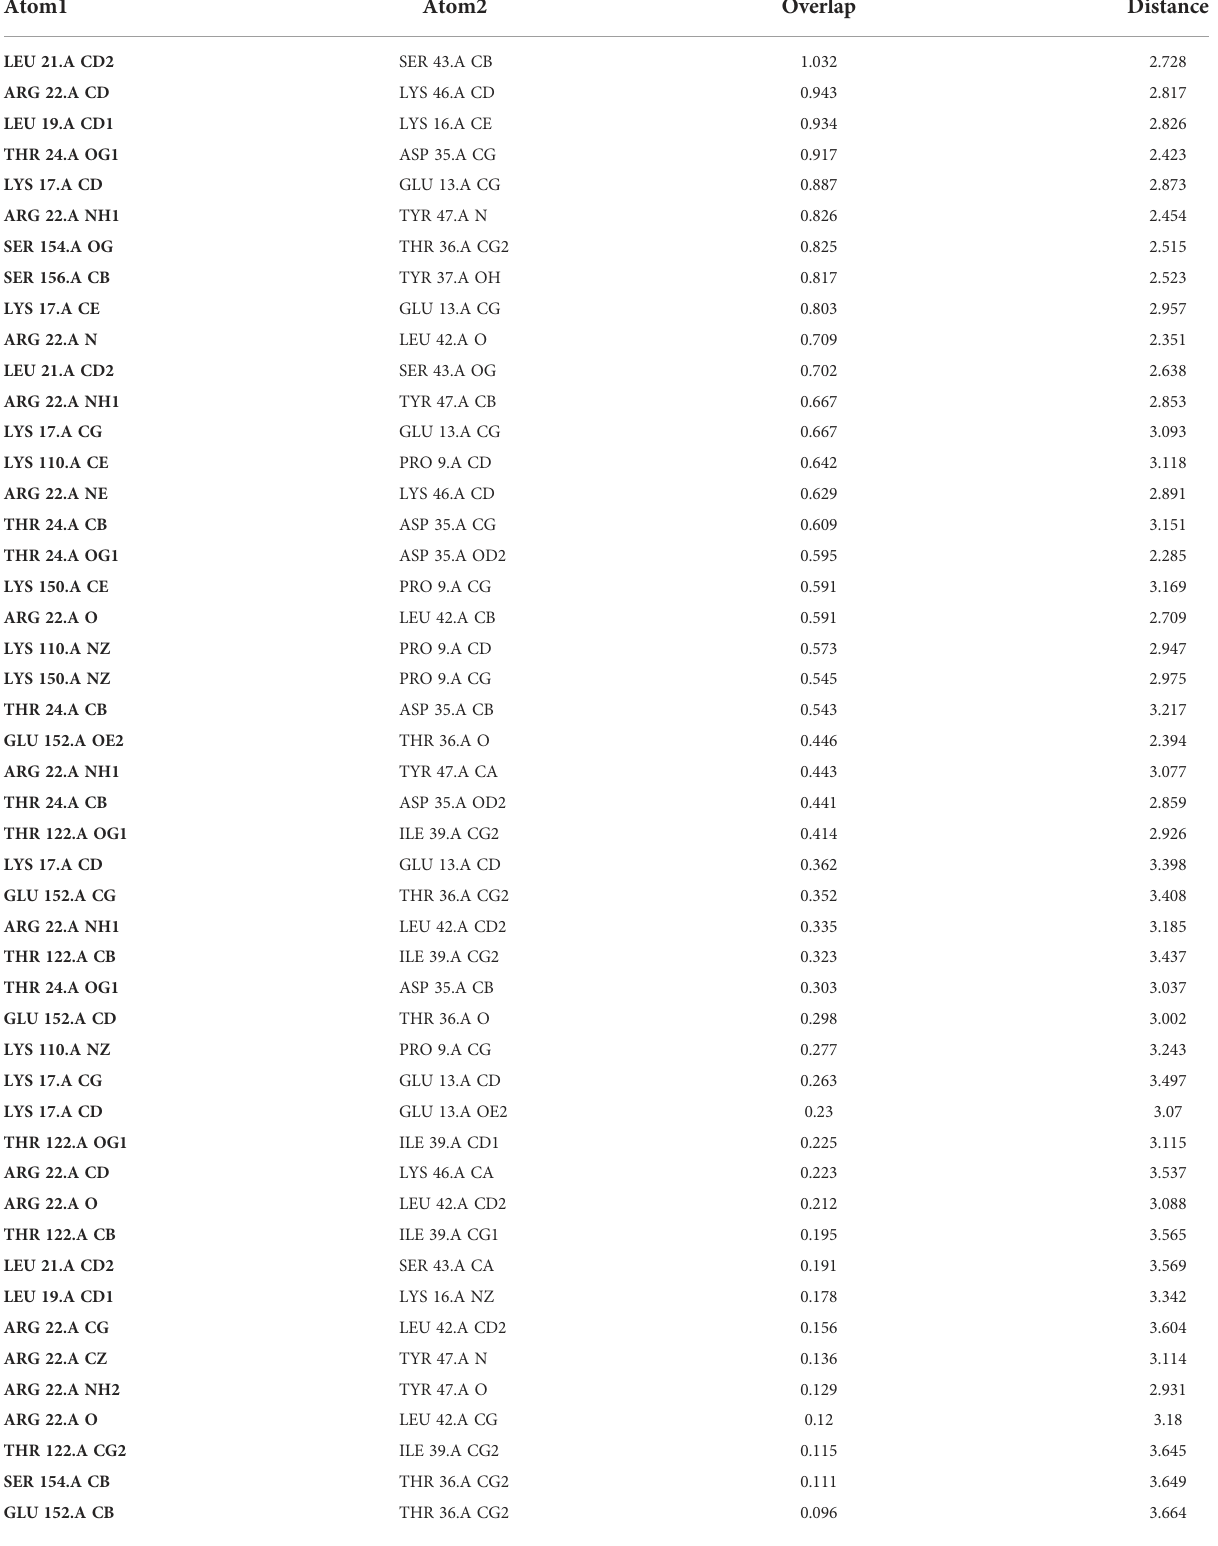
TABLE 3 Contact area for Fas/FasL